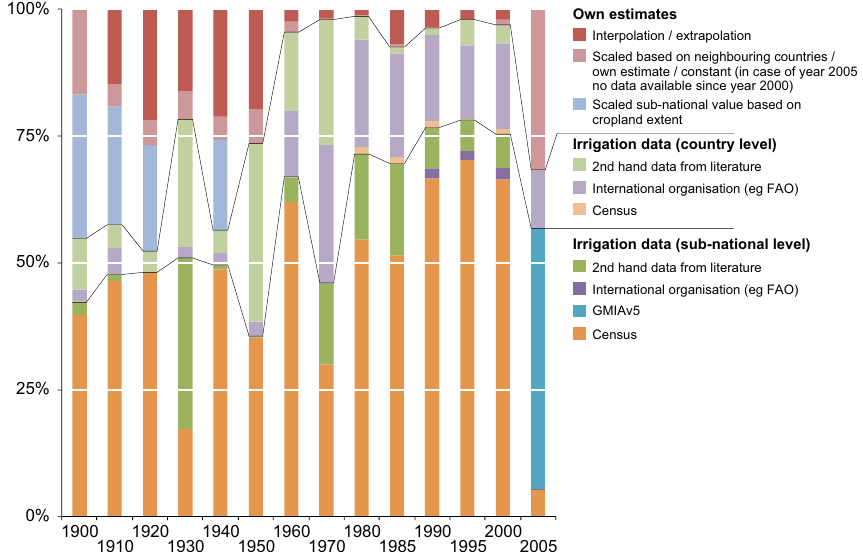
Figure 1. Overview of the types of input data used to develop the sub-national inventory of historical statistics on the area equipped for irrigation (AEI_SU) for the period 1900–2005. Please note that the spatial pattern of AEI_SU in 2005 is mainly determined by version 5 of the Global Map of Irrigation Areas GMIAv5 (Siebert et al., 2013), which again is based on sub-national irrigation statistics, mainly at the second or third administrative unit